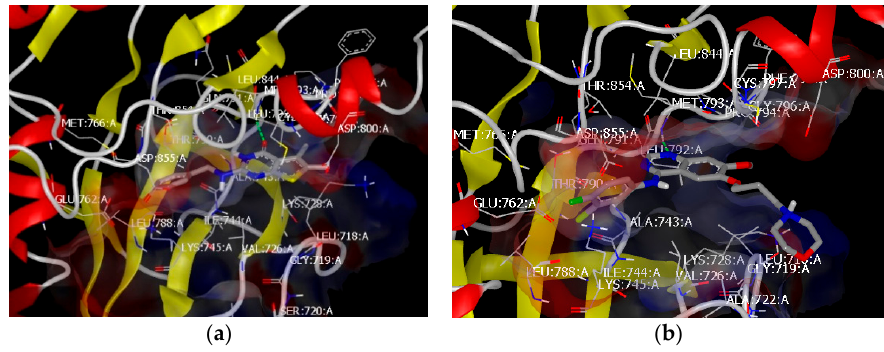
Figure 3. Compound 5a docked in the active site of EGFR tyrosine kinase ( a ), in comparison with selective inhibitor gefitinib docked in the active site of EGFR tyrosine kinase ( b ). Table 1. Anticancer screening data in concentration 10 − 5 M for the most active thienopyrimidines. No.